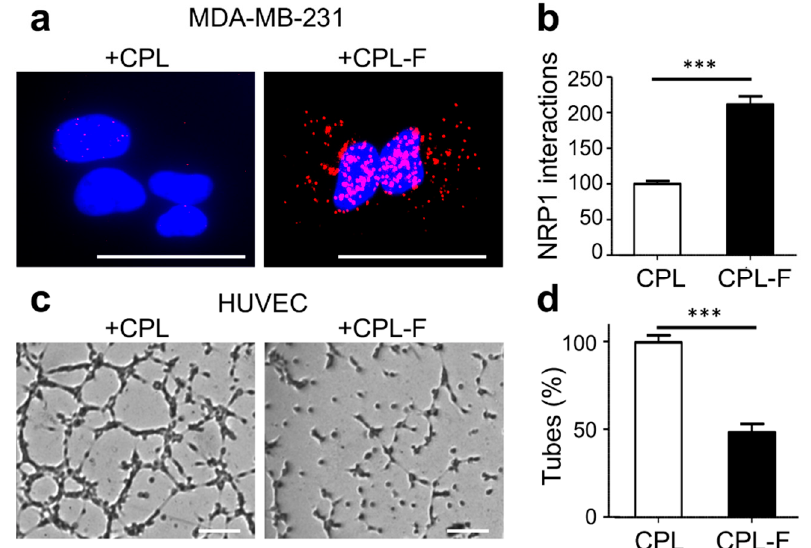
Figure 5. CPL-F interacts with NRP1. ( a , b ) Phenotype ( a ) and quantification ( b ) of interaction of CPL and CPL-F in MDA MB231 cells as determined by PLA with antibodies against NRP1 and MBP. Scale bar, 10 µm. Quantification of NRP1/CPL and NRP1/CPL-K complexes per cell. N = 3 independent experiments with 5–10 imaging fields analyzed per condition. *** p < 0.0001 Mann-Whitney test. ( c , d ) Phenotype ( c ) and quantification ( d ) of tube formation of HUVECs four hours after treatment with CPL or CPL-F. Scale bar, 200 µm. Note a 52% decrease in the formation of tubes with CPL-F. N = 4 experiments. *** p < 0.0001 (Mann–Whitney test).